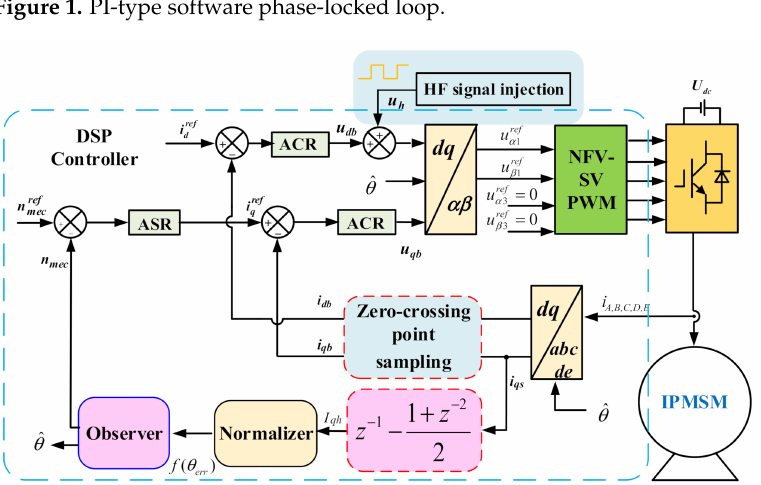
Figure 2. Block diagram of the proposed filterless signal processing method based on HF SWVI